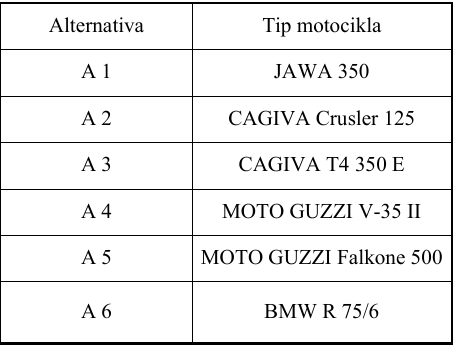
u tabeli 3, a u tabeli 4 date su osnovne karakteristike